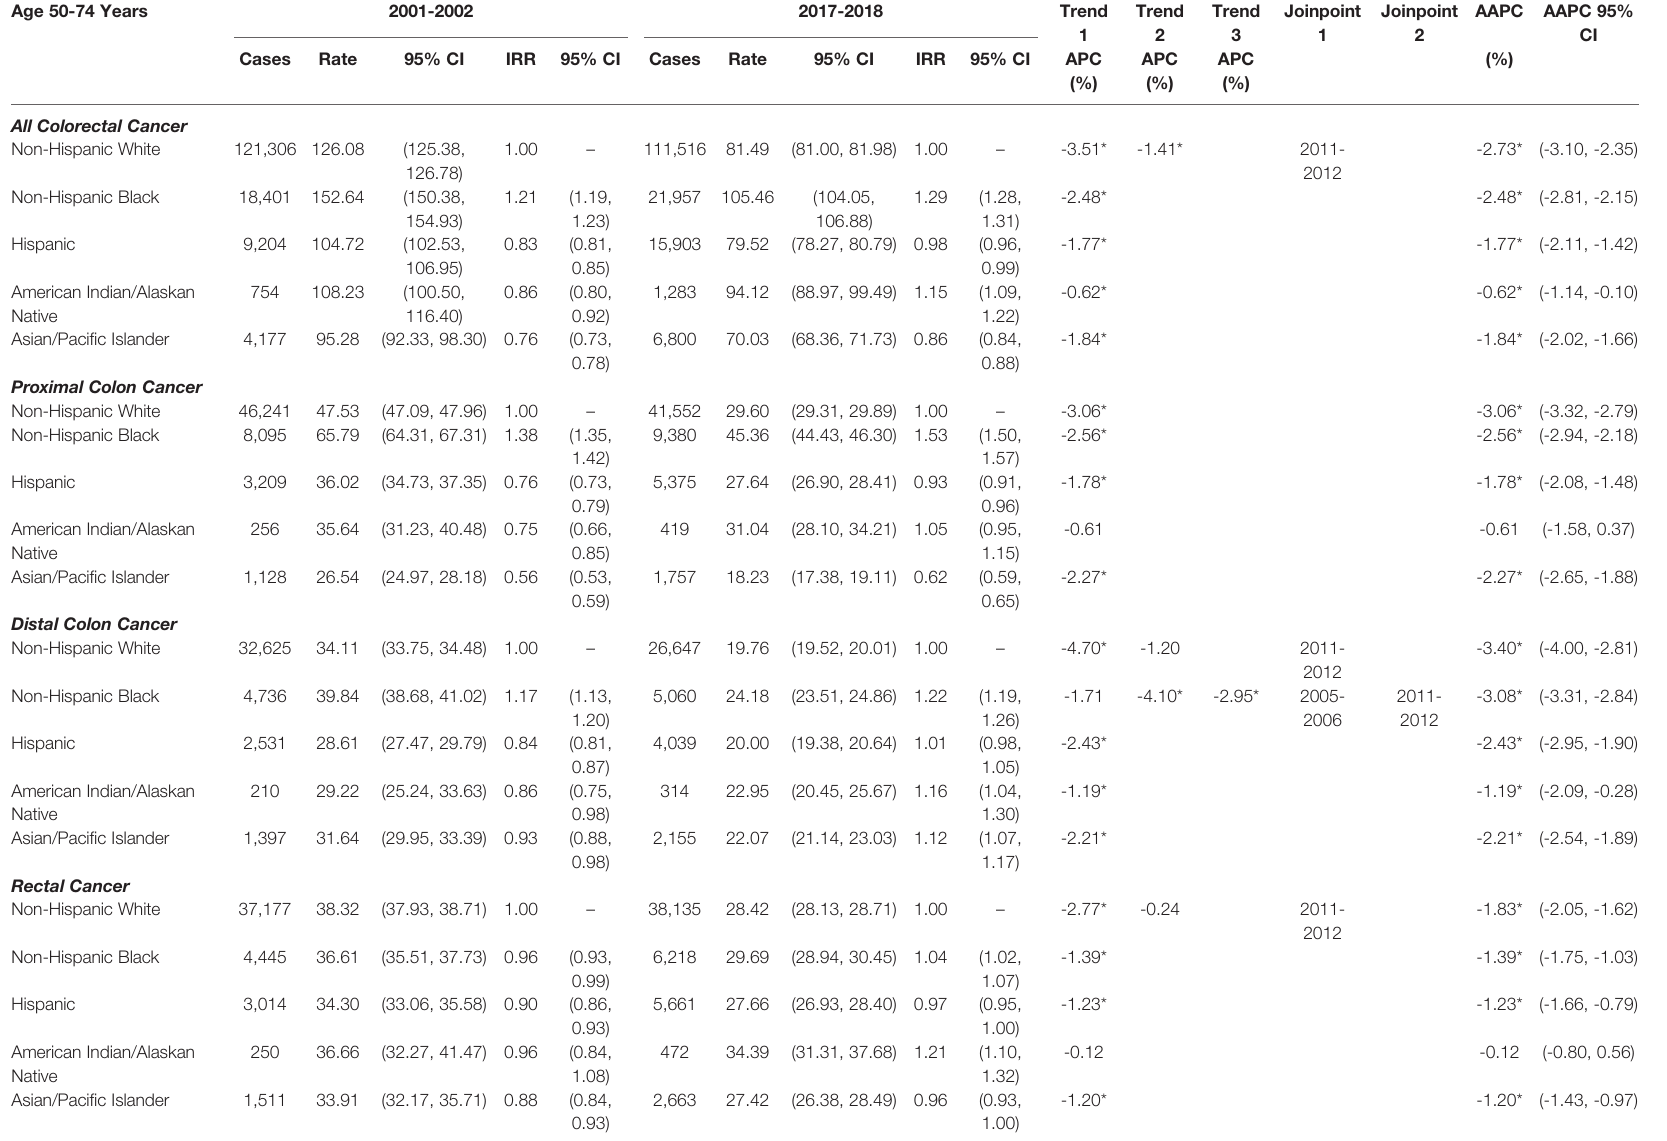
*Statistically signi fi cant at the 0.05 level. IRR, incidence rate ratio; CI, con fi dence interval; APC, annual percent change; AAPC, average annual percent